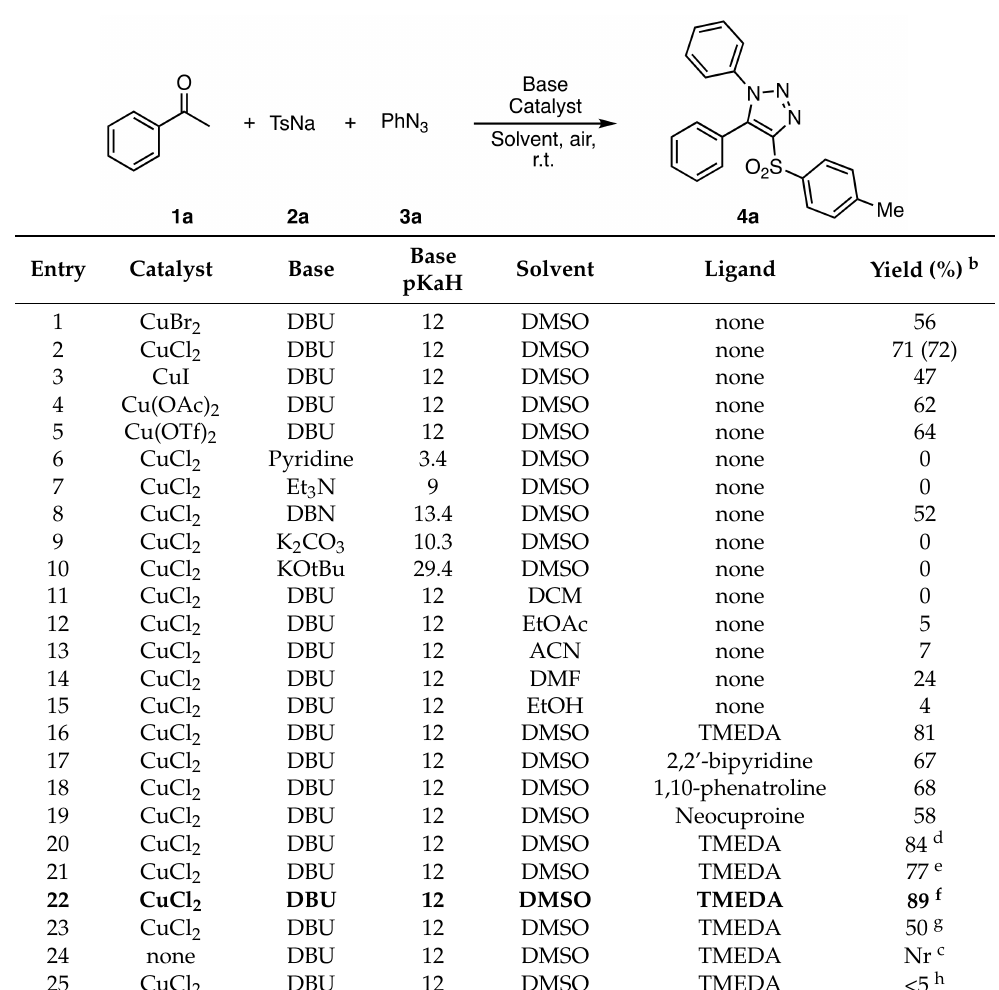
Table 1. Optimization of reaction conditions a